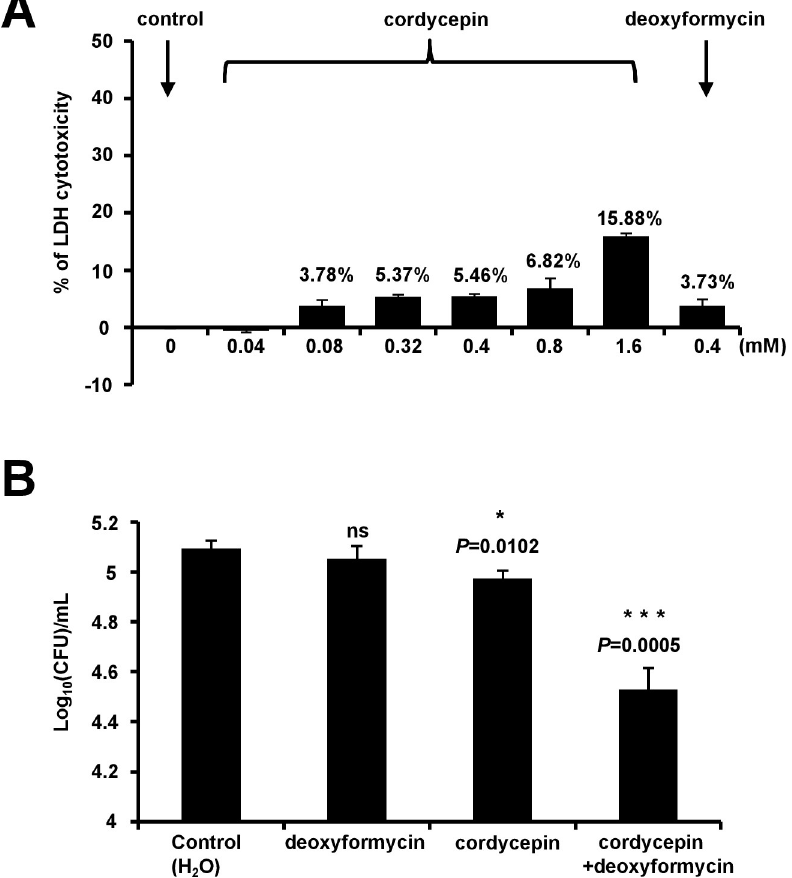
Fig 7. Effects of cordycepin and deoxyformycin on host cell and intracellular Mycobacterium bovis BCG. (A) Determination of LDH cytotoxicity of cordycepin or deoxyformycin in BMDMs. BMDMs (5 × 10 4 cells per well) were plated in a 96-well plate and incubated overnight in an incubator at 37˚C, 5% CO 2 . And on the next day, different concentrations of cordycepin or deoxyformycin were added to the culture media and incubated for 18 hours. LDH cytotoxicity was measured using the Pierce LDH Cytotoxicity Assay Kit. All experiments were repeated three times. Error bars are standard deviations. (B) BMDMs were infected with Mycobacterium bovis BCG (MOI = 1) and treated with 0.4 mM cordycepin or/and 0.4 mM deoxyformycin for 18 h, and the mycobacterial survival was assayed by determining colony-forming units (CFUs). All experiments were repeated three times. Error bars represent the SD in the figure. Asterisks indicate P -values ( � , P < 0.05; ��� , P < 0.001) from the unpaired two-tailed Student’s t -test using GraphPad Prism 5.